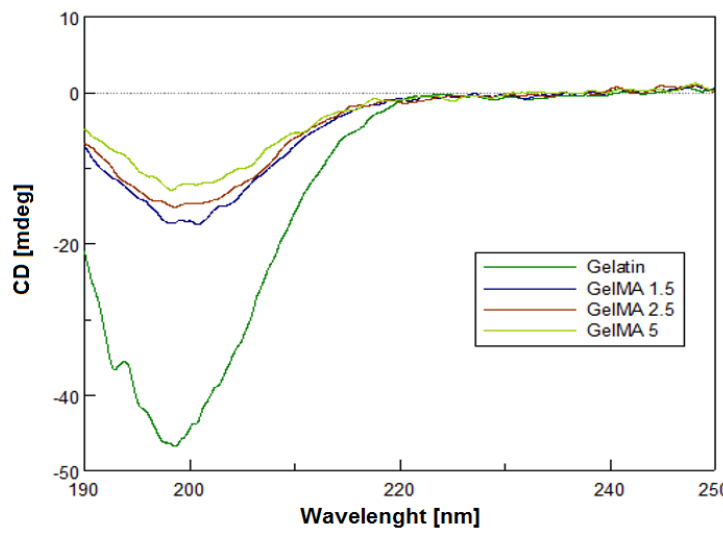
Figure 5. Rough overlapping CD spectra (190 – 250) of gelatin and GelMA samples.